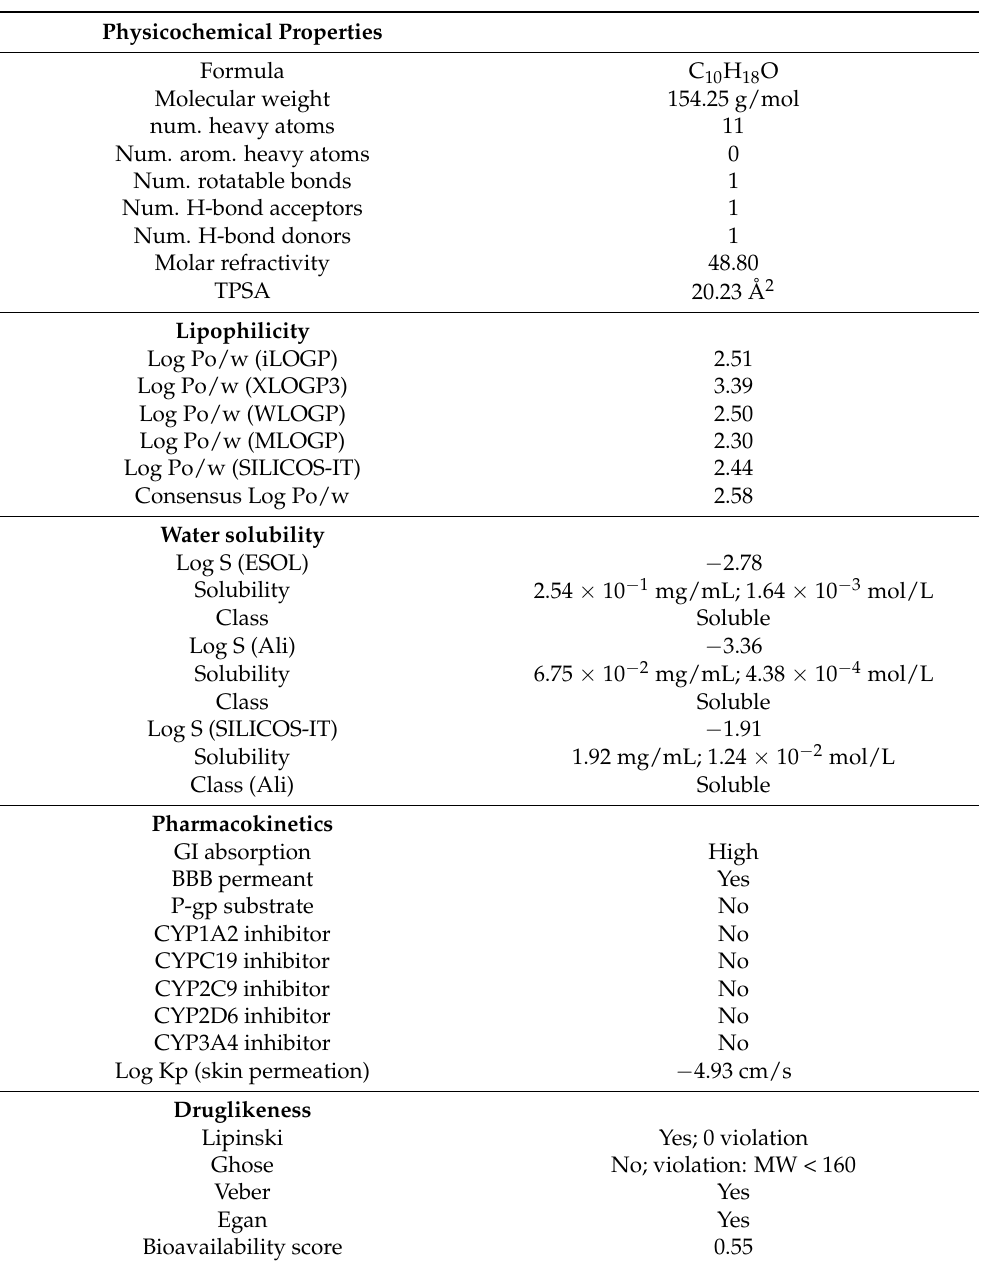
Table 7. In silico study of the pharmacokinetic parameters of α -terpineol. Parameters are in- terpreted as follows: Class (Ali): insoluble < − 10 < poorly soluble < − 6 < moderately soluble < − 4 < soluble < − 2 very soluble < 0 highly soluble; Log Po/w ≤ 5; Lipinski: MM ≤ 500, H- bond donors ≤ 5, H-bond acceptors ≤ 10; Ghose: 180 ≤ MM ≤ 480, 20 ≤ number of atoms ≤ 70, 40 ≤ molar refractometry ≤ 130, − 0.4 ≤ Log Po/w ≤ 5.6—Veber: number of rotatable bonds ≤